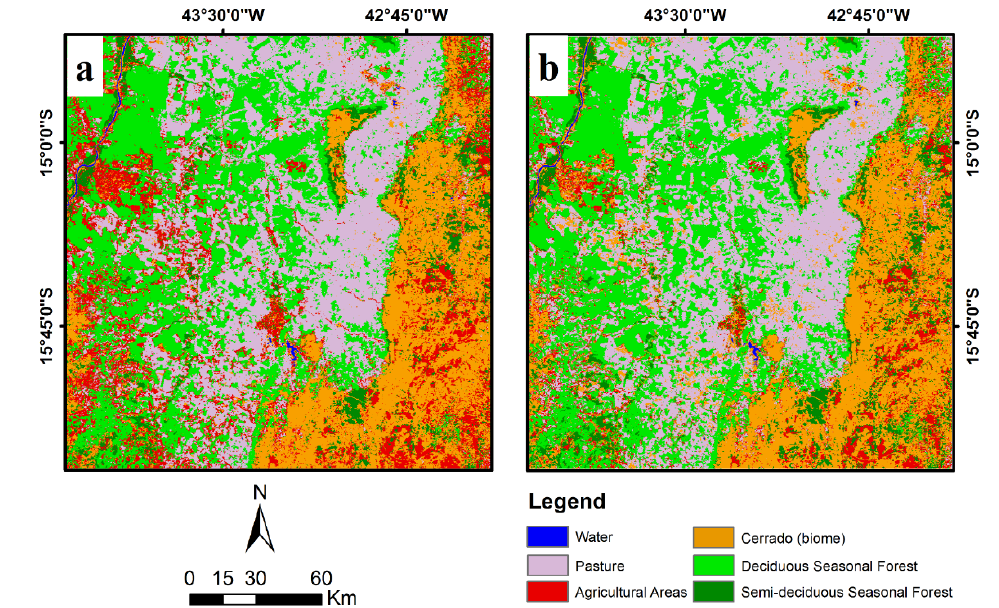
Figure 11. Comparison between the classifications considering six classes: ( a ) SVM (fourth-degree polynomial kernel) and ( b )